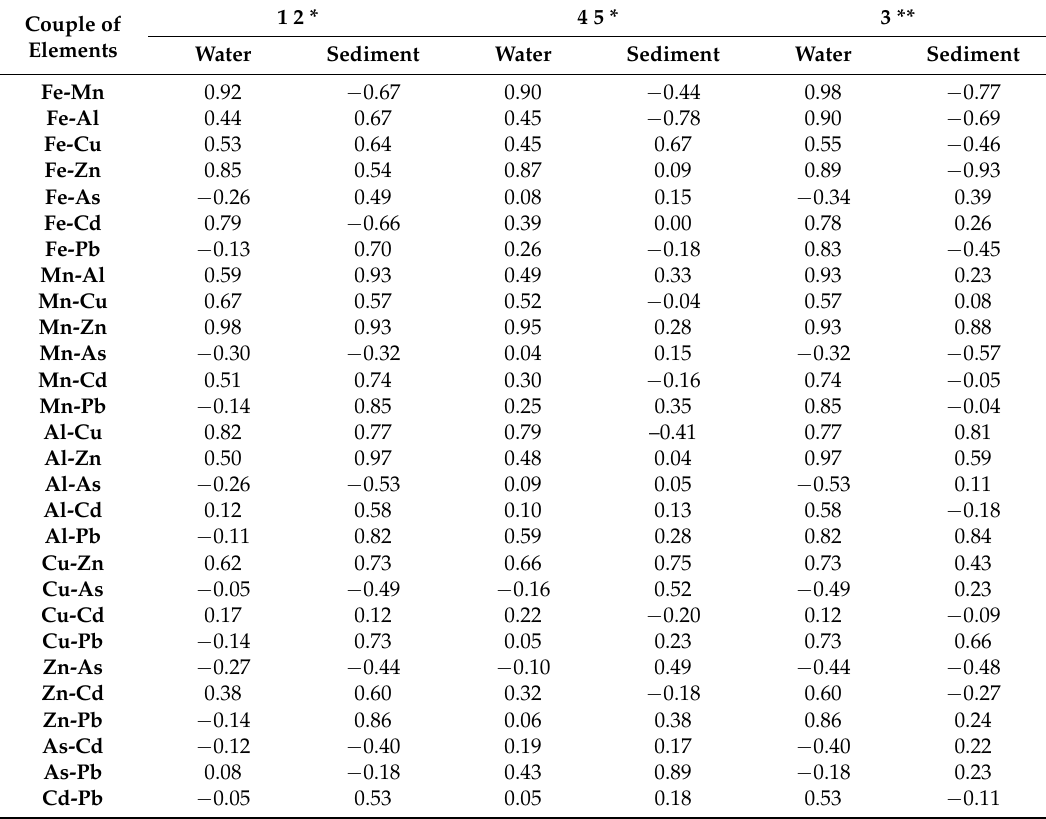
Table 5. Pearson product moment correlation coefficients between metal levels in the media. Couple of